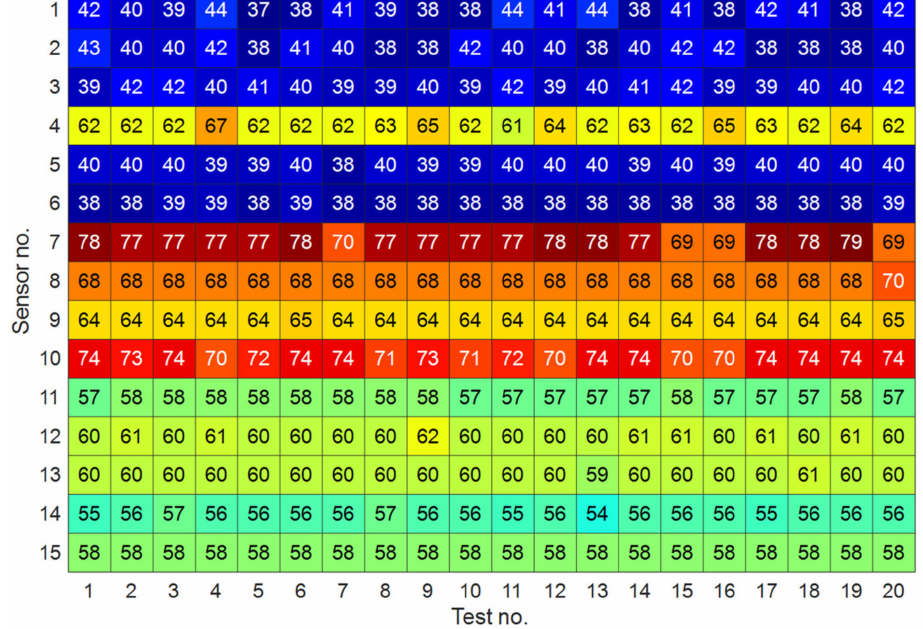
Figure 4. Average AR orders for all sensor locations and test measurements relevant to HC1 and HC2.